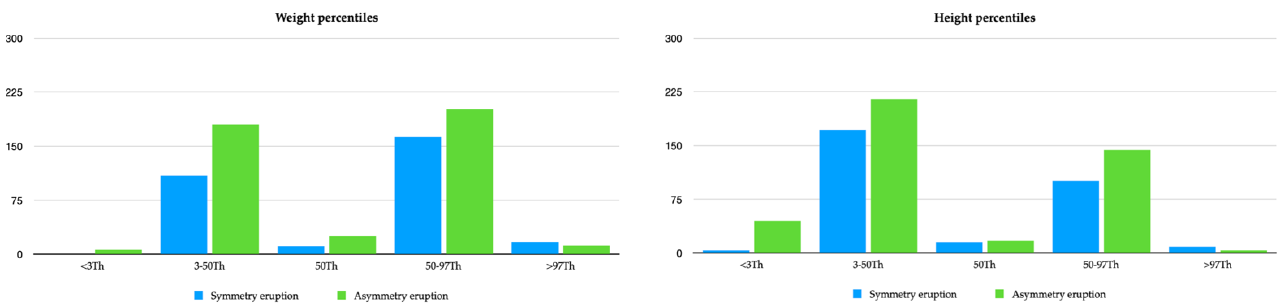
Table 3. Eruption of the incisor group and its relationship with weight and height percentile. De- scriptive and comparative statistics: absolute and relative frequencies; contingency tables and Fisher ’ s exact test. Weight Percentiles